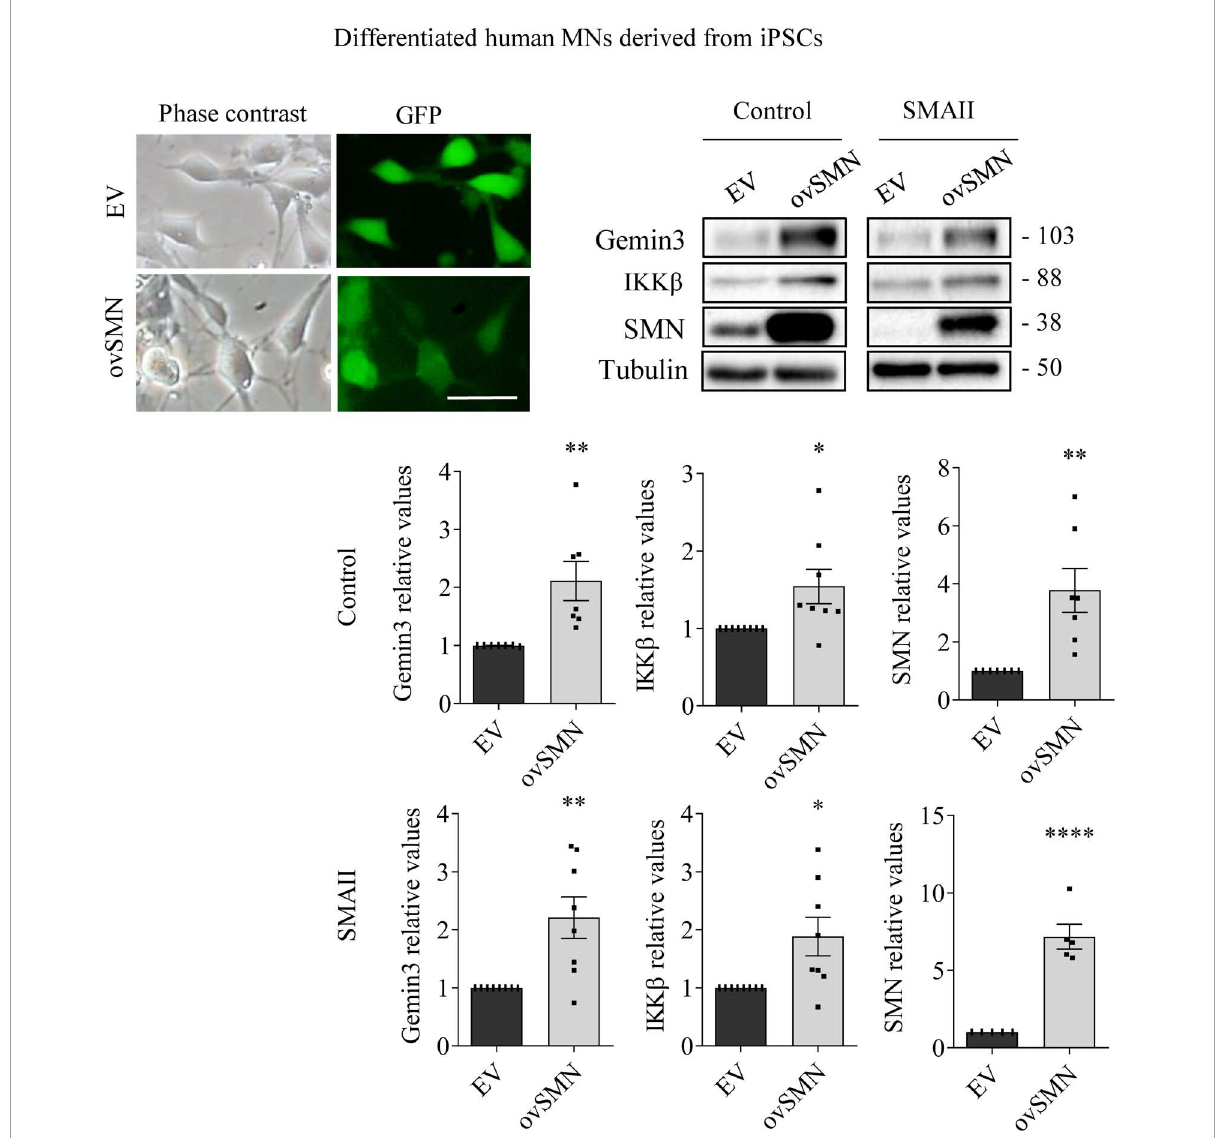
FIGURE6 Survival motor neuron (SMN) overexpression increased Gemin3 and IKK β protein level in differentiated human motoneurons (MNs). Control and SMAII human MNs were plated and transduced with lentiviral vectors carrying ovSMN construct or the empty vector (EV). Representative microscopy images of 7 days EV or ovSMN transduced cultures: phase contrast and GFP. GFP indicates Green Fluorescent Protein expressing cells in the same microscopic field. Scale bar, 20 µ m. Total cell lysates were submitted to western blot analysis using anti-Gemin3, anti-IKK β , and anti-SMN antibodies. Membranes were reprobed using anti- α -tubulin antibody. Graph values represent the expression of Gemin3, IKK β or SMN versus α -tubulin and correspond to the quantification of at least five independent experiments ± SEM. Asterisks indicate significant differences using Student t -test ( ∗ p < 0.05; ∗∗ p < 0.01; ∗∗∗∗ p <